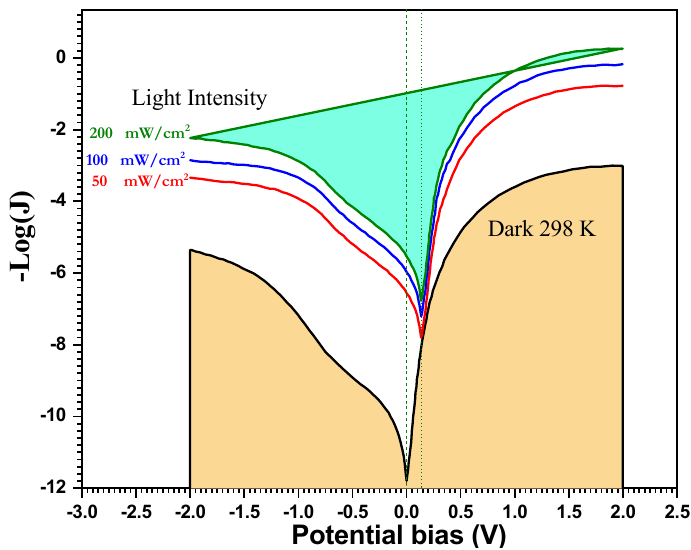
Figure 15. − log(J)–(V) characteristics curves for Au/[ PoPDA/TiO 2 ] MNC /n-Si/Al heterojunction diode under dark with T = 298 K and the different illuminations 50 ≤ Illuminations ≤ 200 mW/cm − 2 Table 5. The values of the nonlinear coefficient parameters ( (cid:1870) (cid:2869) (cid:1853)(cid:1866)(cid:1856) (cid:1870) (cid:2870) ) for Au/[ PoPDA/TiO 2 ] MNC /n- Si/Al heterojunction diode.